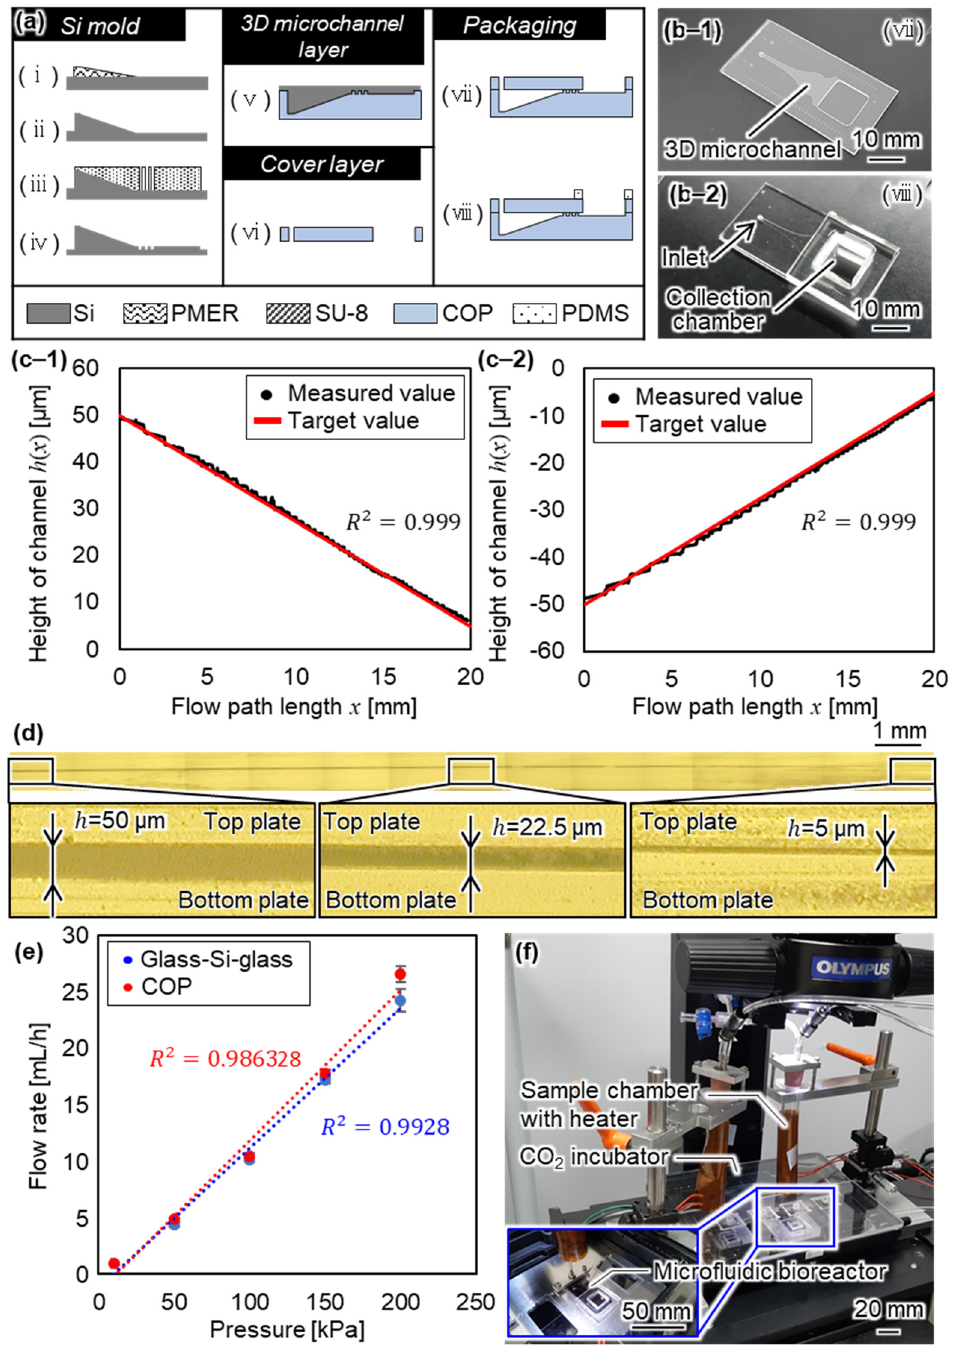
Figure 4. Fabrication of the COP microfluidic bioreactor. ( a ) Process flow of the fabrication of the microfluidic bioreactor, ( b-1 ) Photograph after the bonding of COP-COP layers, ( b-2 ) Photograph after bonding of the COP-PDMS layers, ( c ) Height evaluation of ( c-1 ) The fabricated Si mold and ( c-2 ) The fabricated microchannel of the COP, ( d ) Merged image of the cross-section of the 3D microchannel after bonding, ( e ) Evaluation result of the flow rate, and ( f ) Photograph of the constructed system.